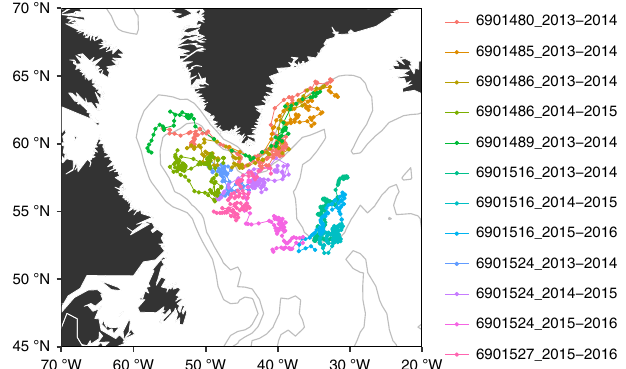
Fig. 1 Locations of the 12 time series analysed in the study. The name of the various time series includes the fl oat ’ s World Meteorological Organization (WMO) number followed by the 2 years sampled by the fl oats. Note that a same fl oat can acquire several time series NATURE COMMUNICATIONS | (2018) 9:190 | DOI: 10.1038/s41467-017-02143-6 |